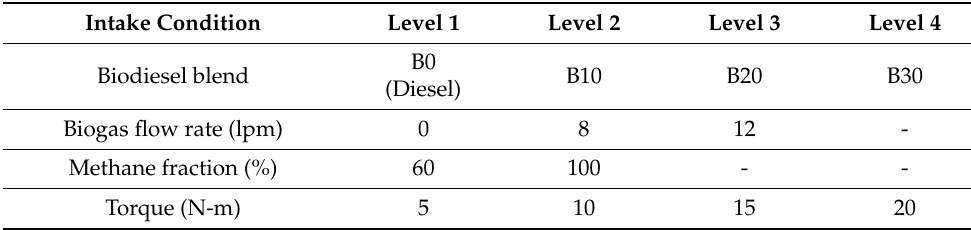
Table 2. Operating